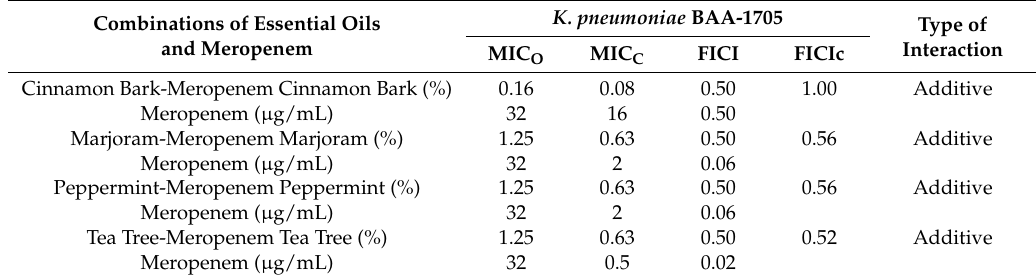
Table 1. Minimum inhibitory concentration (MIC) and FIC indices of essential oil-meropenem pairs against K. pneumoniae